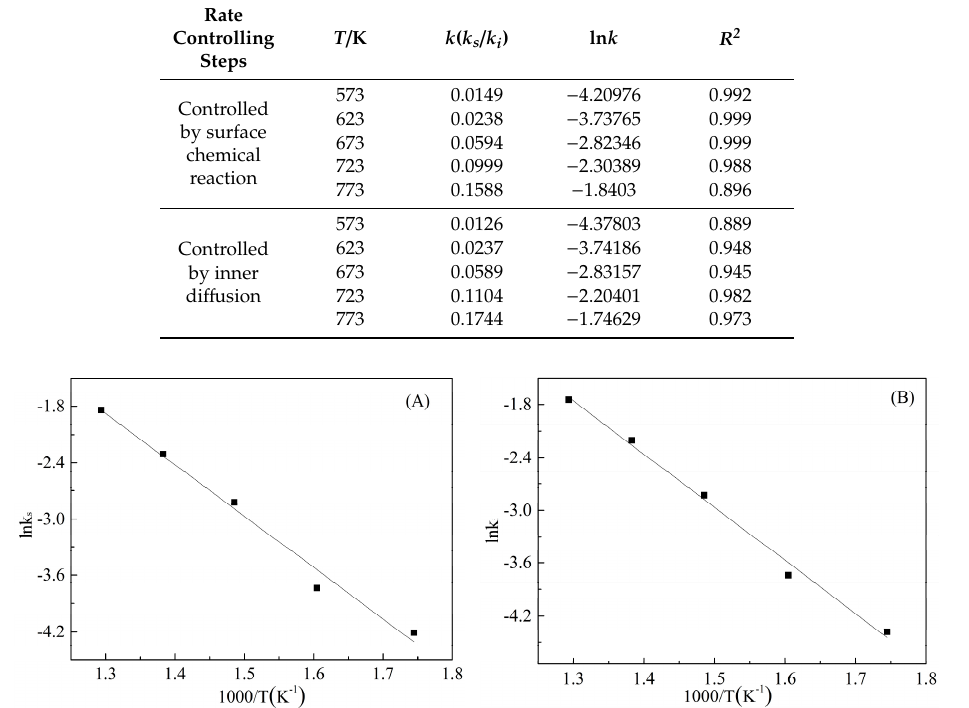
Figure 11. Arrhenius linear fittings of the reduction reaction controlled by the surface chemical reaction ( A ) and inner diffusion ( B ). reaction ( A ) and inner di ff usion ( B